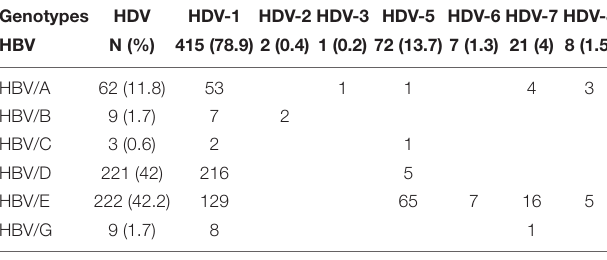
Number and percentage of strains are indicated.